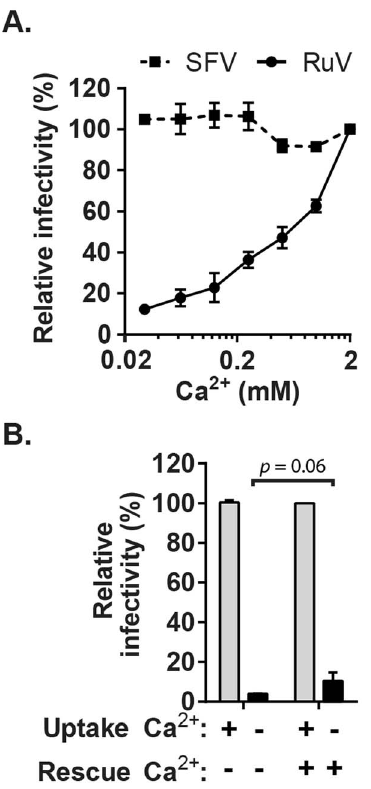
Figure 1. Effect of Ca 2 + on RuV infection. (A) RuV or SFV was pre- bound to Vero cells on ice for 90 min in binding medium. Cells were shifted to 37 u C for 20 min in medium containing the indicated concentrations of CaCl 2 , and then cultured for 48 h at 37 u C in growth medium plus 20 mM NH 4 Cl to prevent secondary infection. Infected cells were scored by immunofluorescence. Infectivity was normalized to that observed at 2 mM CaCl 2 , which was , 15% infected cells. (B) RuV was prebound to Vero cells as in panel A and incubated at 37 u C for 20 min in medium with or without 2 mM CaCl 2 (Uptake). The cells were then incubated for 1 h at 37 u C in medium with or without 2 mM CaCl 2 , to test if infection could be rescued by the addition of Ca 2 + (Rescue). The cells were then cultured for 48 h at 37 u C in growth medium plus 20 mM NH 4 Cl, scored by immunofluorescence, and infectivity normal- ized to that observed when 2 mM CaCl 2 was present throughout the experiment. Data in A are the mean and range of 2 independent experiments. Data in B are the mean and standard deviation from 3 independent experiments. Statistical analysis was performed in (B) using a paired Student’s t